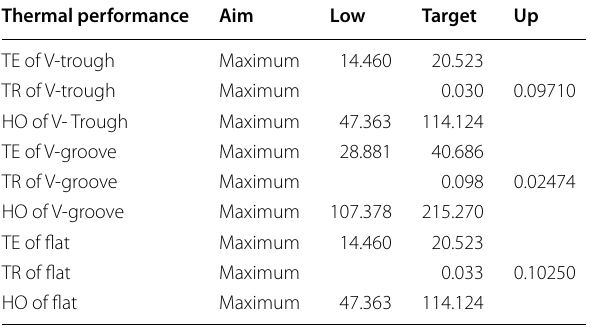
Table 6 Limits and targets for responses